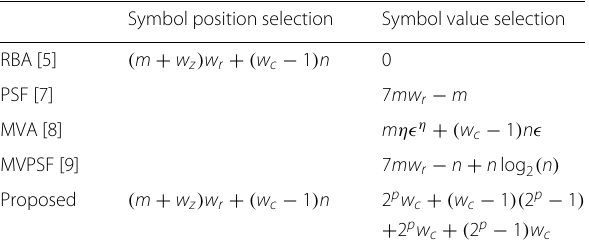
Table 1 Number of real operations for the symbol flipping algorithm